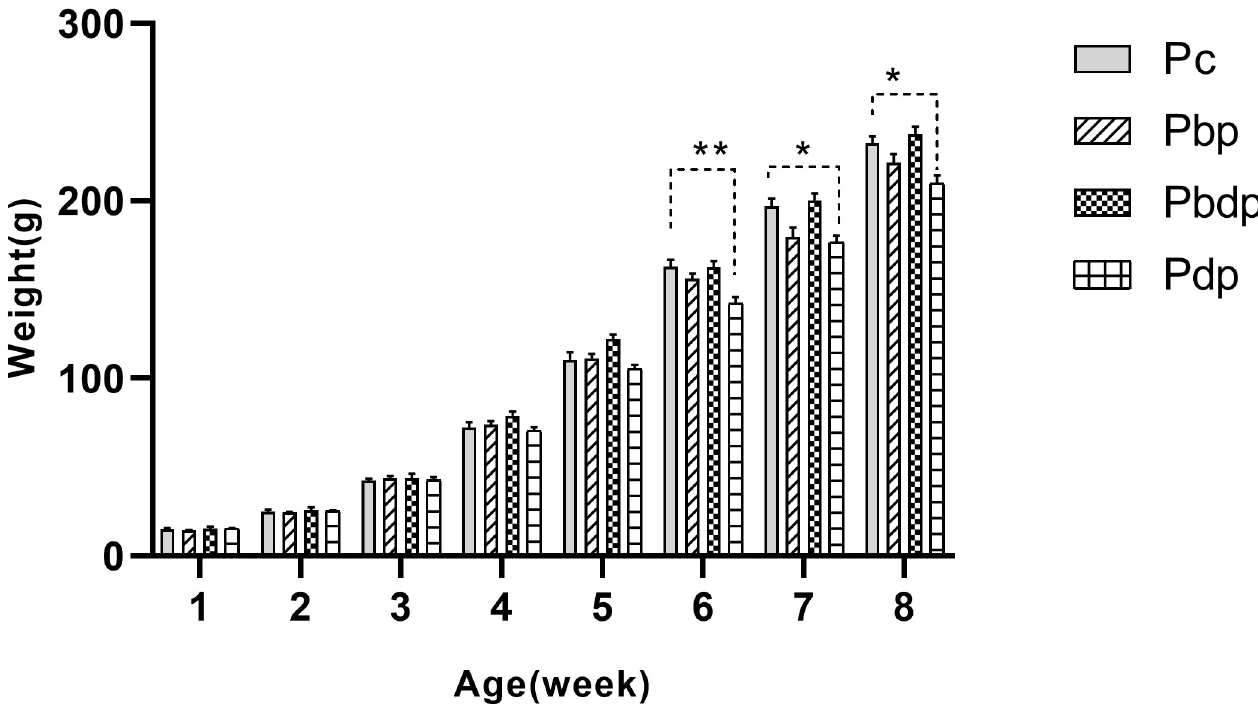
Fig 2. Comparison of the weekly weight gain among the pup groups. Abbreviations: P c group (n = 5), pups of sedentary mothers; P bp group (n = 6), pups of mothers who exercise only before pregnancy; P bdp group (n = 4), pups of mothers who exercise prior to and during pregnancy; P dp group (n = 6), pups of mothers who exercise only during pregnancy. Data presented as means ± S.E.M. � p < 0.05 and �� p < 0.01 vs. Pup Control group. Two-way ANOVA followed by Dunnett’s multiple comparisons test.